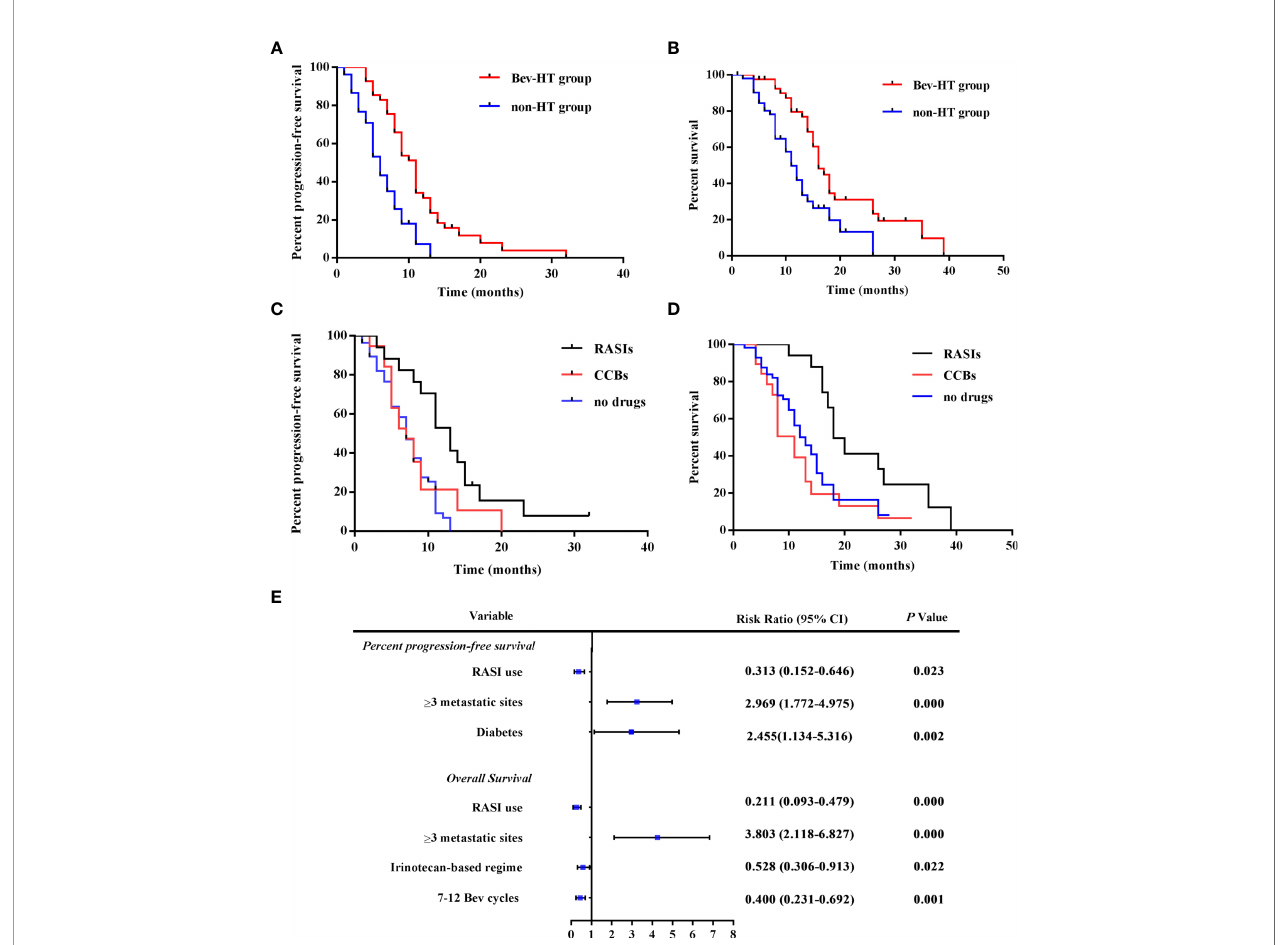
FIGURE 1 | RASI adjunctive treatment improves survival in patients with mCRC. (A) PFS curves according to hypertensive status. (B) OS curves according to hypertensive status. (C) PFS curves according to antihypertensive treatment. (D) OS curves according to antihypertensive treatment. (E) The results of multivariate analysis of patient characteristics. HT, hypertension; RASIs, renin-angiotensin system inhibitors; CCBs, calcium channel blockers; SBP, systolic blood pressure; DBP, diastolic blood pressure; Bev, bevacizumab; 95% CI, 95% con fi dence